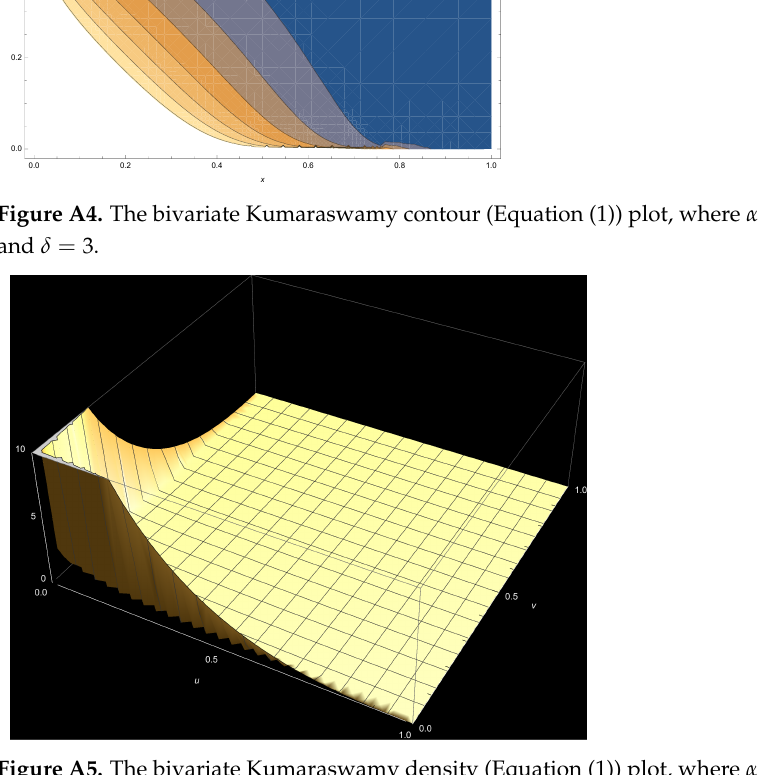
Figure A5. The bivariate Kumaraswamy density (Equation (1)) plot, where α = 0.8, β = 0.8, θ = 0.4 and δ = 3.